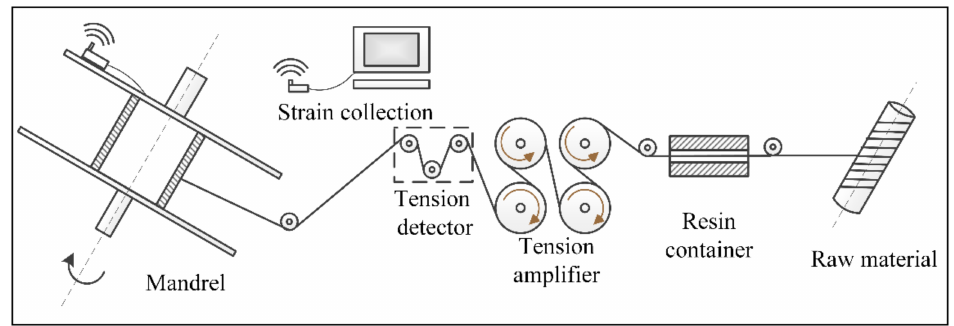
Figure 1. Schematic and equipment of winding